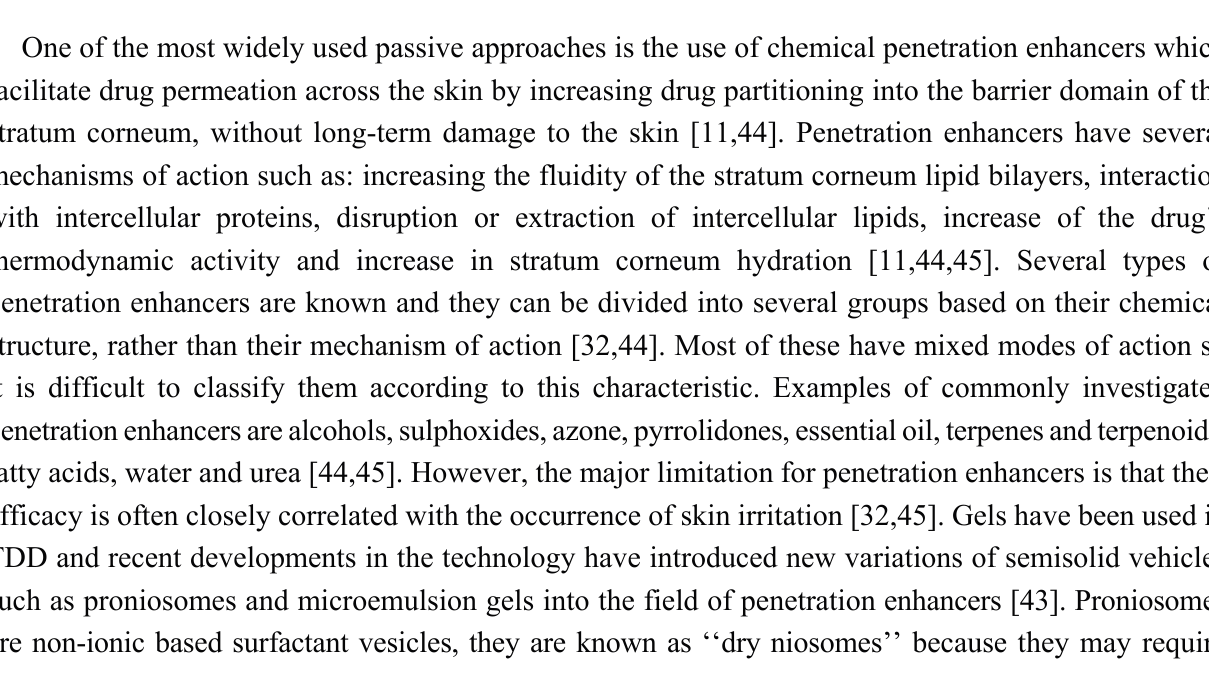
Figure 5. Approaches for enhancing drug transport across the